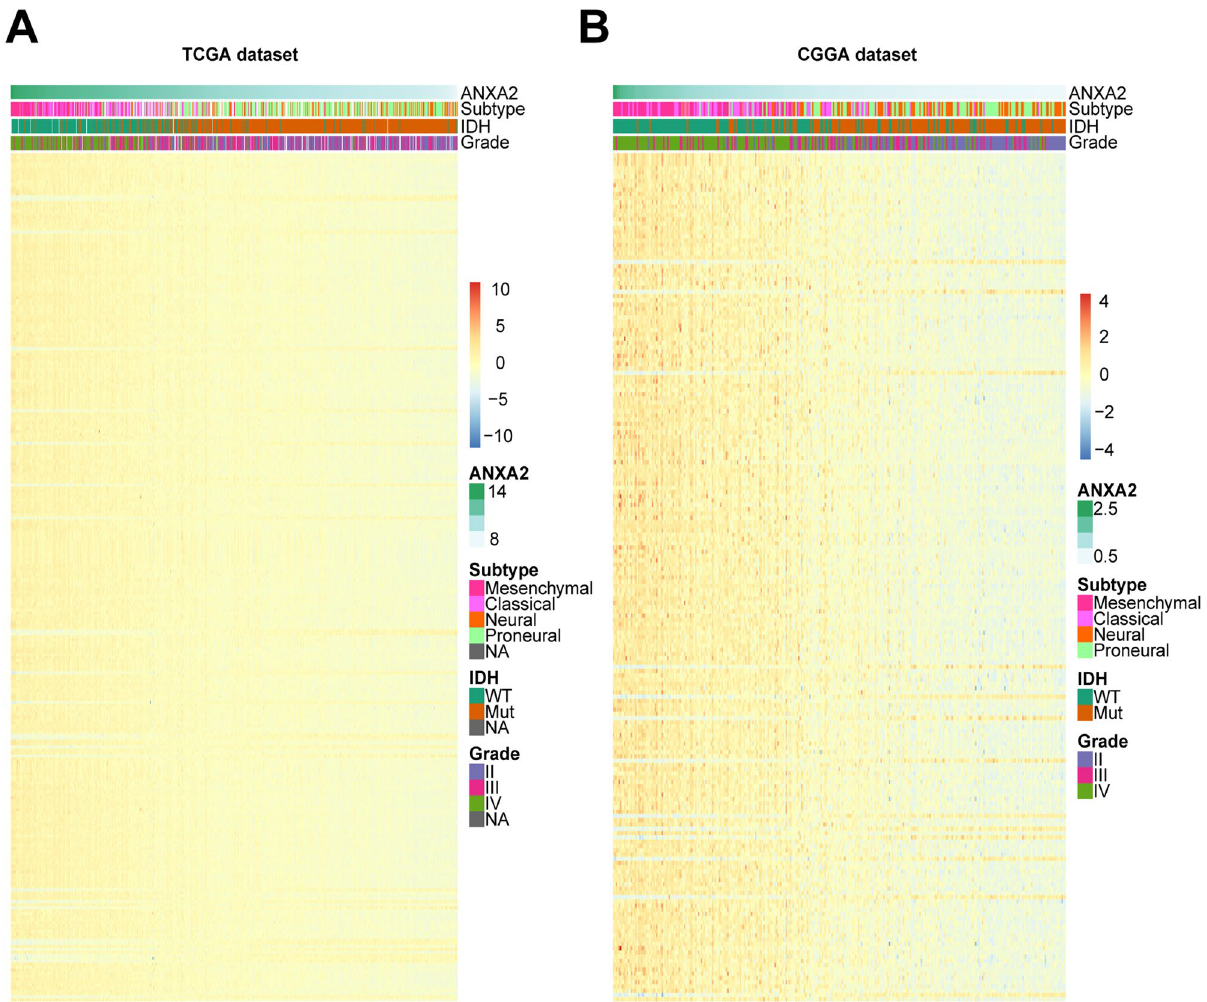
Figure 6. Heatmap analysis of the relationship between ANXA2 and immune function-related genes in glioma. The results showed that ANXA2 had a markedly positive correlation with most immune genes in both TCGA ( A ) and CGGA ( B )